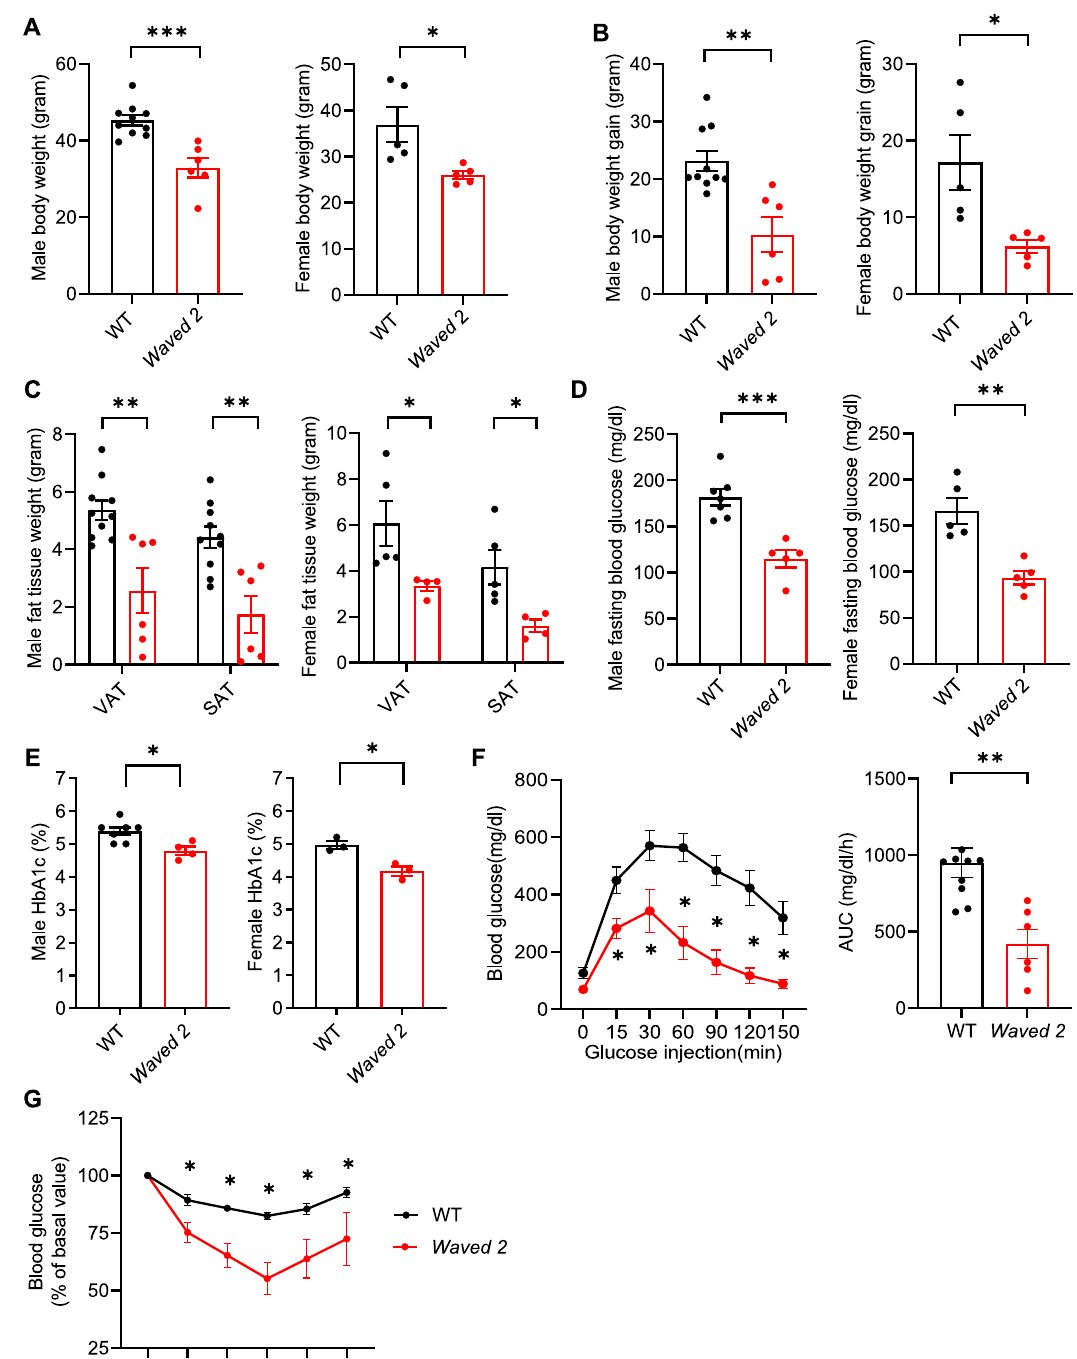
Fig. 1 | Waved 2 mice developed less metabolic derangement in diet induced obesity. Waved 2 micewith intrinsic EGFR tyrosine kinase de fi ciencyand WT mice were fedthe HFD for 12 weeks. A , B Both male and female Waved2 mice hadlower body weight (Male: n =6 and 10; female: n =5) A and body weight gain (Male: n =6 and 10; female: n =5) B . C Both male and female Waved 2 mice had less visceral adiposetissue(VAT)andsubcutaneousadiposetissue(SAT)masscomparedtoWT mice (Male: n =6 and 10; female: n =4 and 5). D , E Both male and female Waved